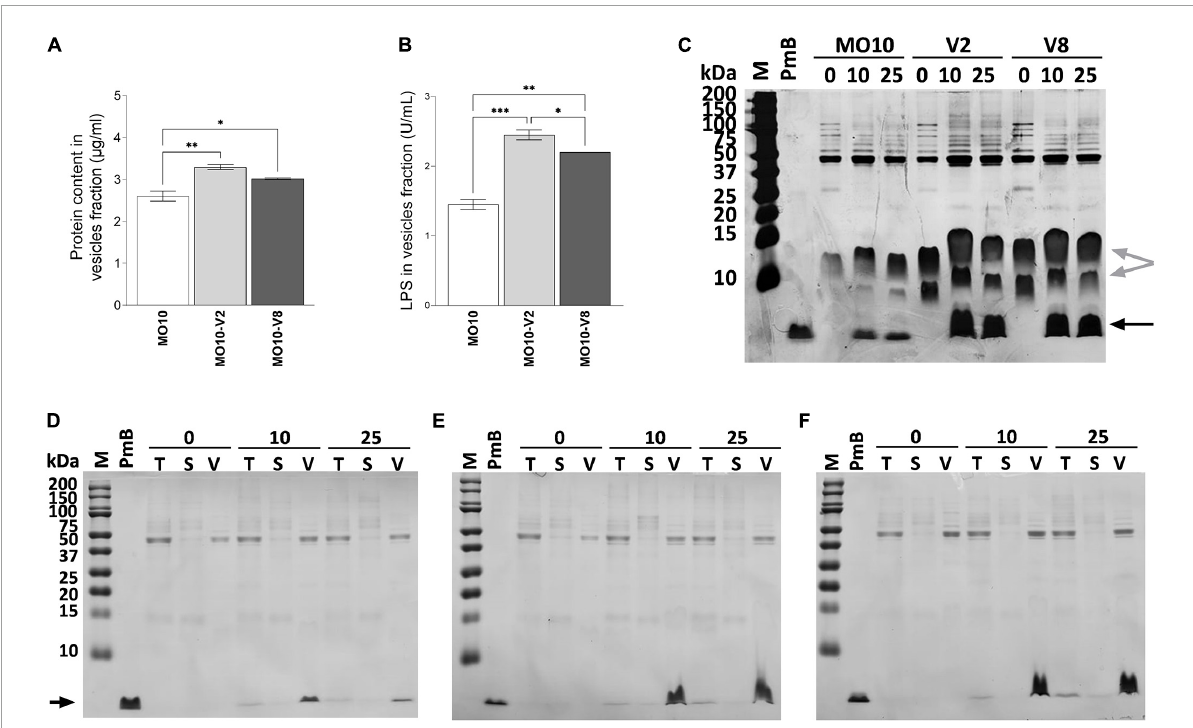
FIGURE7 MO10-V2 and MO10-V8 variants produce more membrane vesicles and titer more polymyxin B than MO10-WT. The membrane vesicles were isolated by ultracentrifugation. The protein content (A) and LPS (B) of the vesicles isolated from MO10-WT (MO10) and its hypermotile variants, MO10-V2 and MO10-V8 cultures were quantified. Data represent mean values ± standard error of the mean from at least three independent experiments. (* p < 0.05; ** p < 0.005; *** p < 0.0001). The polymyxin B (PmB) titration capacity of the vesicles from MO10-WT (D) , -V2 (E), and -V8 (F) was assessed by incubating the cell-free culture supernatant with 0, 10, or 25 µ g/ml of PmB (0, 10, and 25, respectively). Samples from total culture supernatant (T), vesicles (V), and vesicles-free supernatant (S) were analyzed. Proteins were visualized on SDS-PAGE after Coomassie blue staining. PmB alone was used as control of the PmB size (black arrow). (C) The vesicle fraction from MO10-WT, -V2, and -V8 incubated with or without 10 or 25 µ g/ml of PmB migrated on an SDS-PAGE gel. A silver nitrate coloration of the gel shows LPS (gray arrows) and PmB (black arrow). Gel pictures are representative of at least three independent